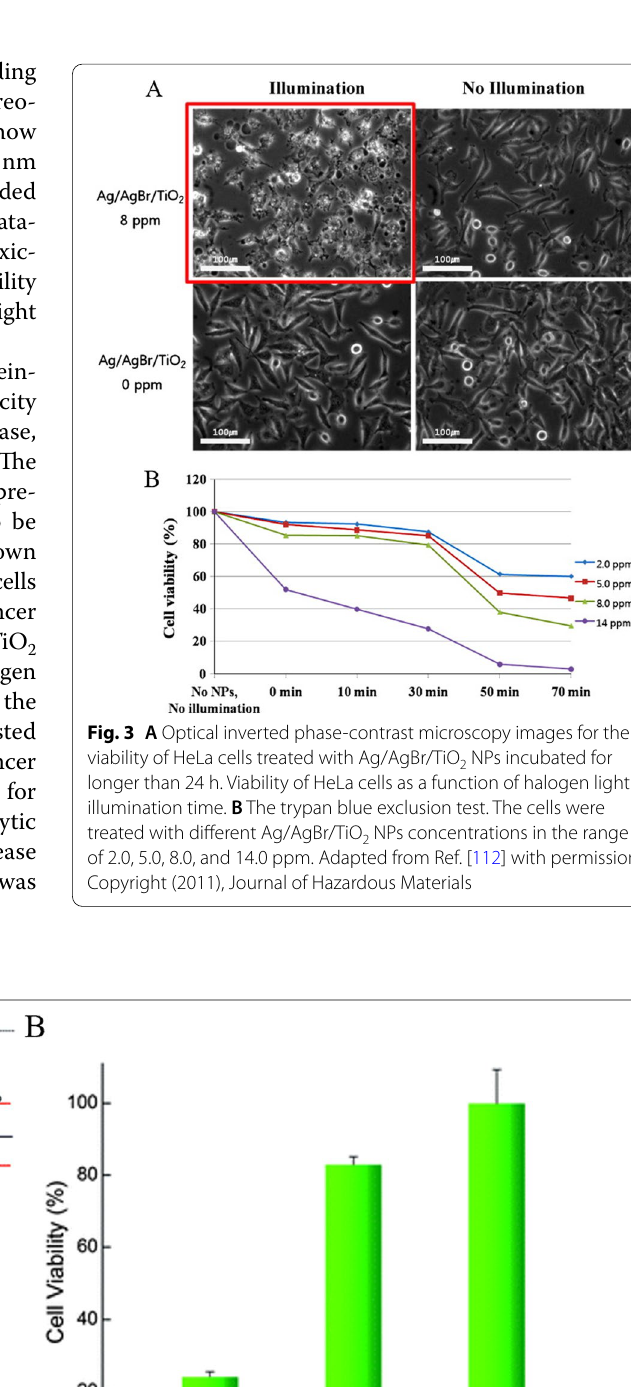
) and without ( ) the Ag/AgCl nanostructures + −